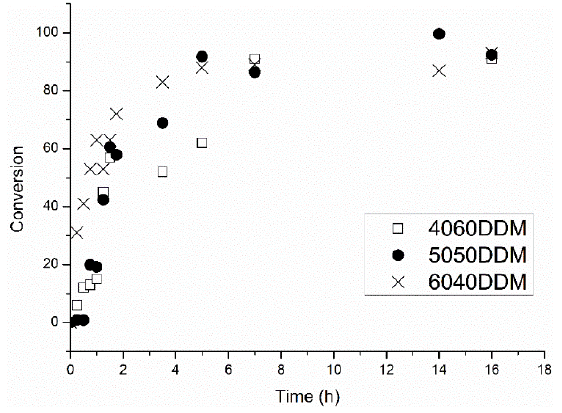
Figure 3. Conversion vs. time calculated from the FTIR spectra for samples containing different bisphenol A diglycidyl ether (DGEBA)/ Polycaprolactone (PCL) ratios cured with DDM.